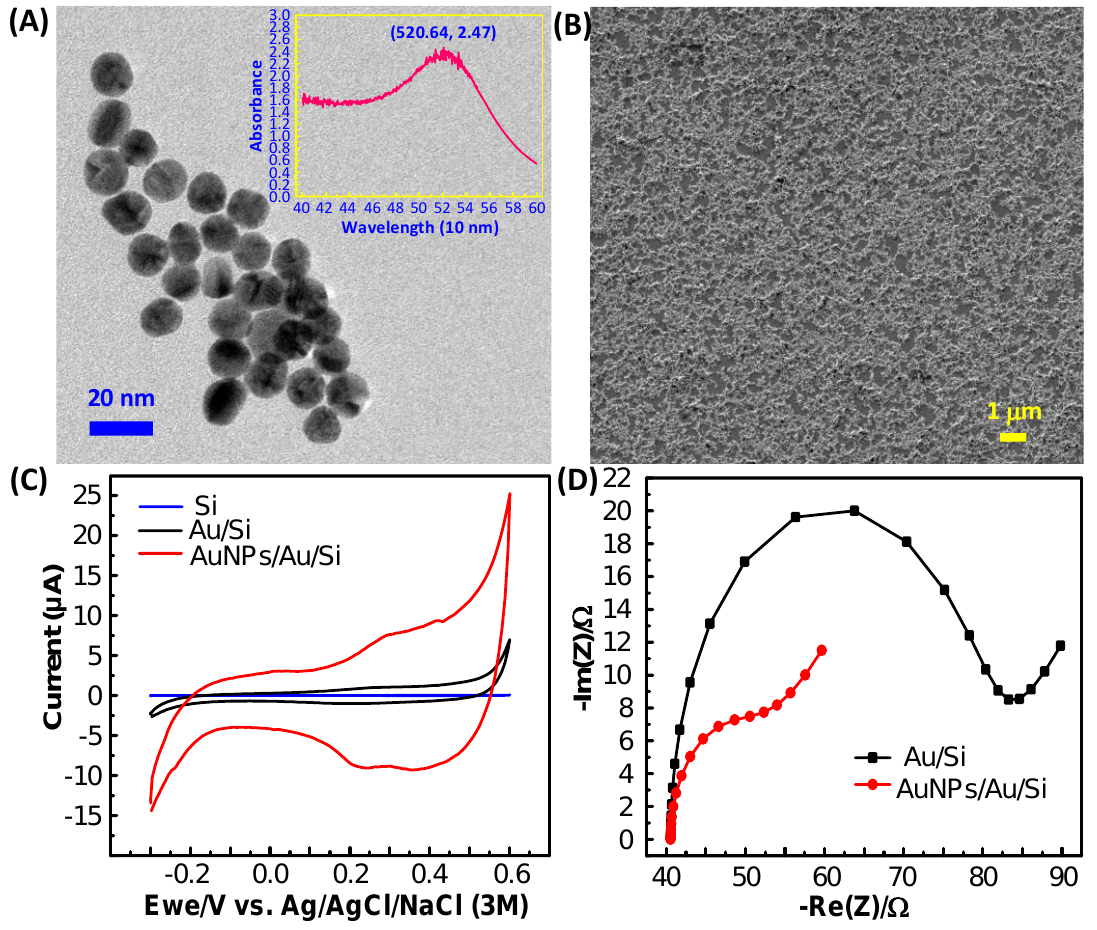
Figure 1. Electrode characterization. ( A ) TEM image of the colloidal AuNPs used for forming the monolayer AuNPs electrode on the silicon substrate, ( B ) SEM image of the monolayer AuNPs electrode on the silicon substrate, ( C ) CV curves of the fabricated electrodes, and ( D ) Nyquist plots of the fabricated electrodes.